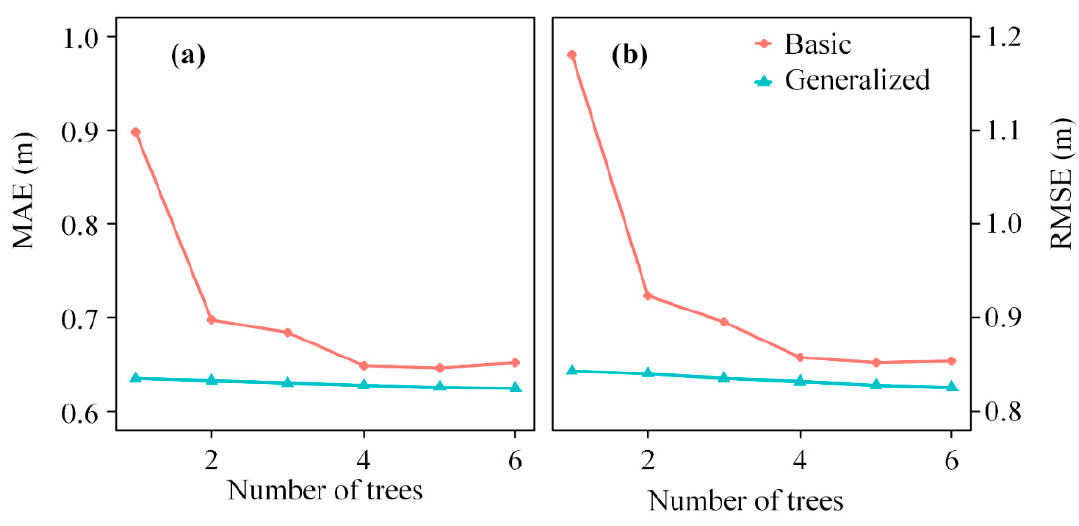
the bottom to the top indicate DH values from 4 m ( red ) to 16 m ( black ) with a step of 2 m. The